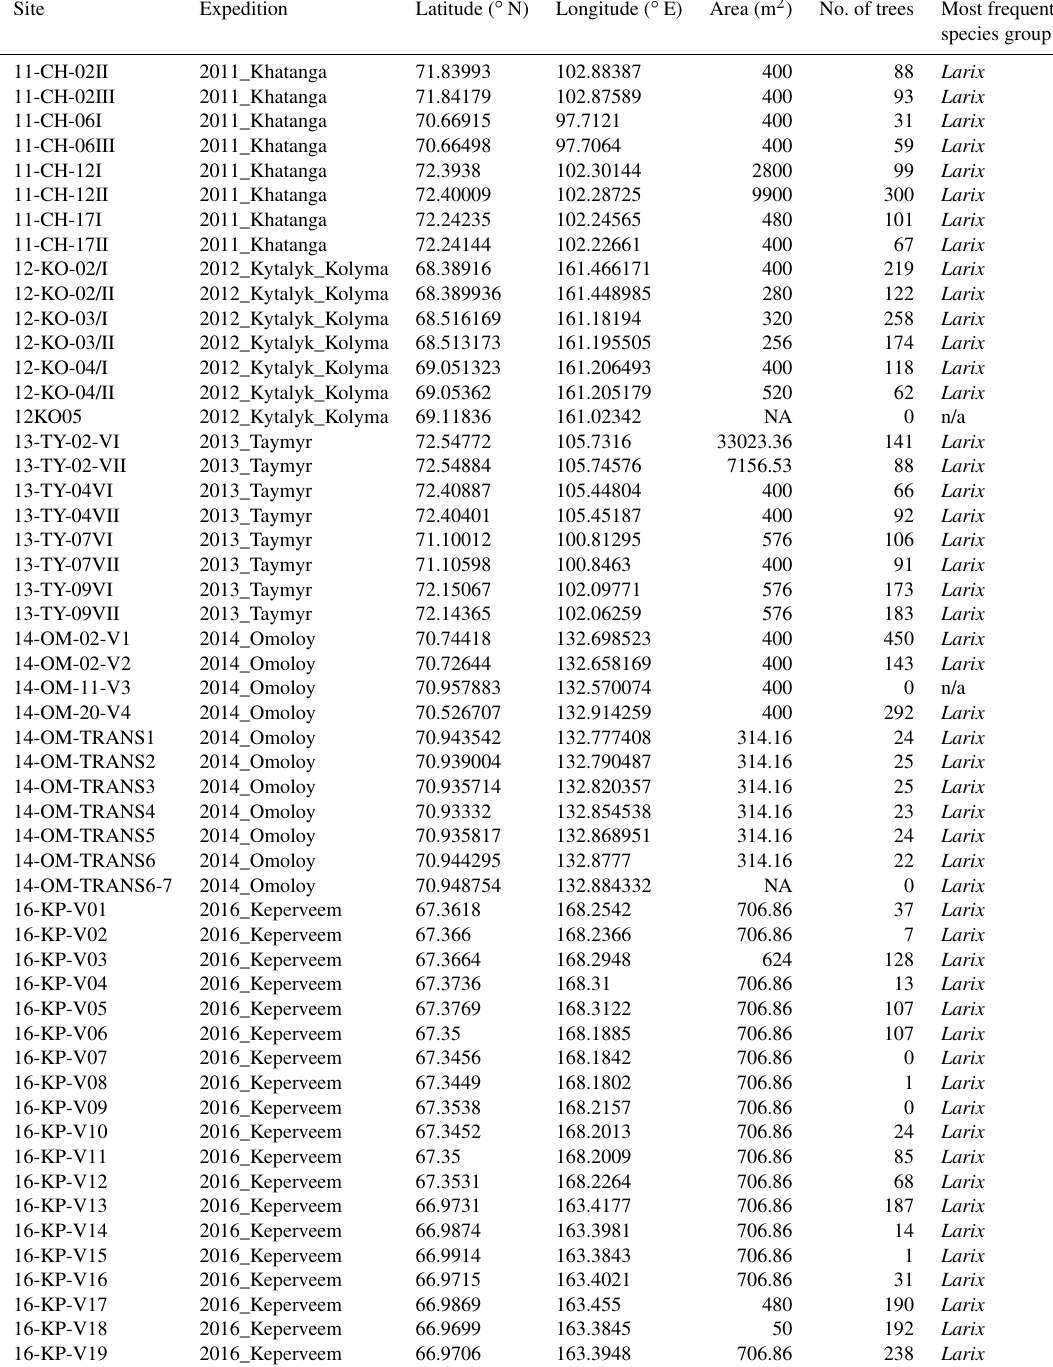
Table A1. Overview over all vegetation plots. NA: not available. n/a: not